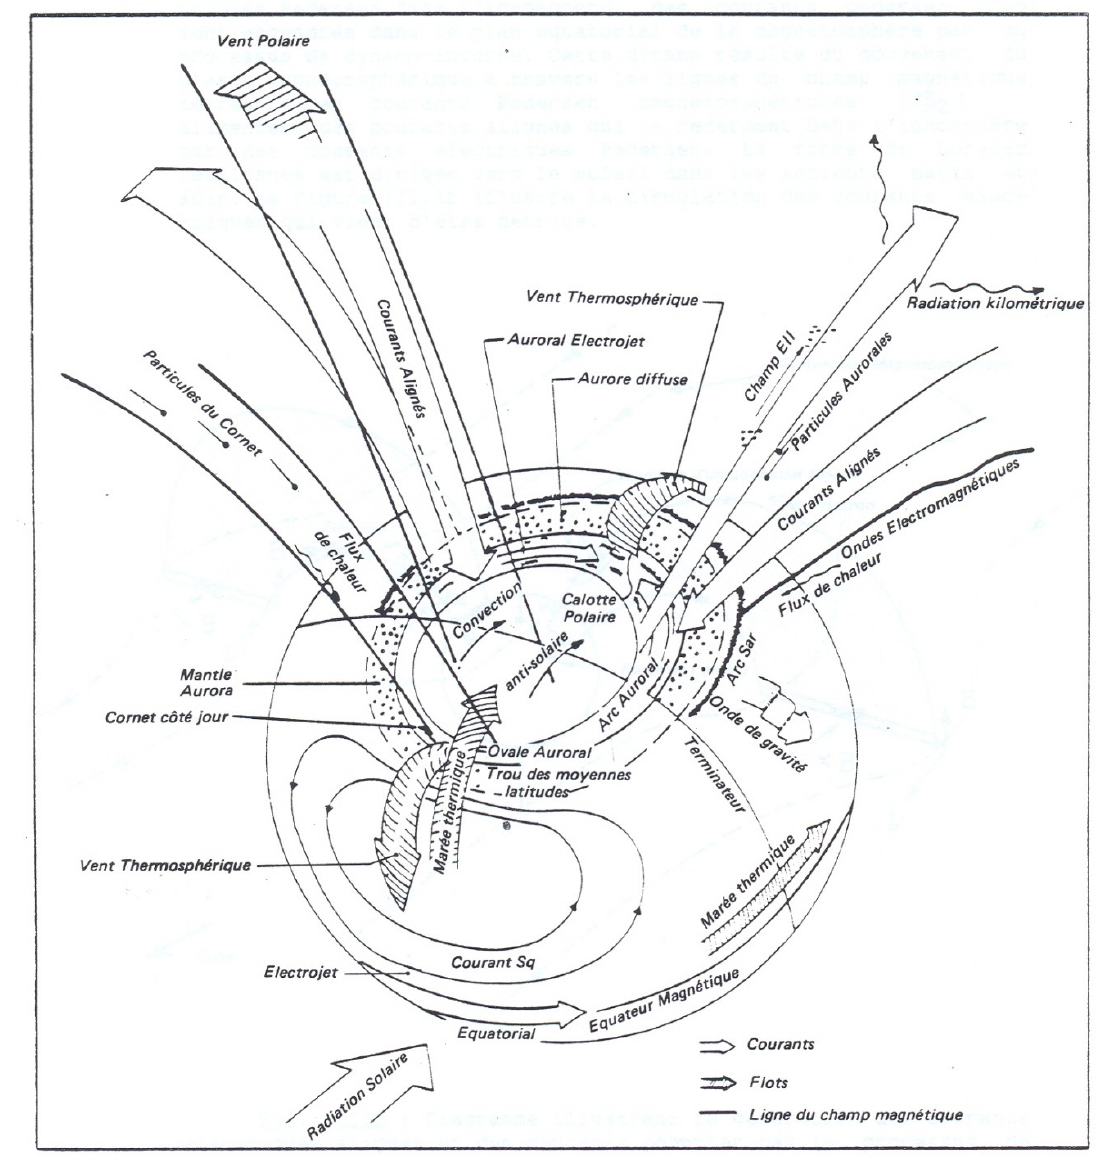
Figure 5. Electric currents in the ionosphere [27].